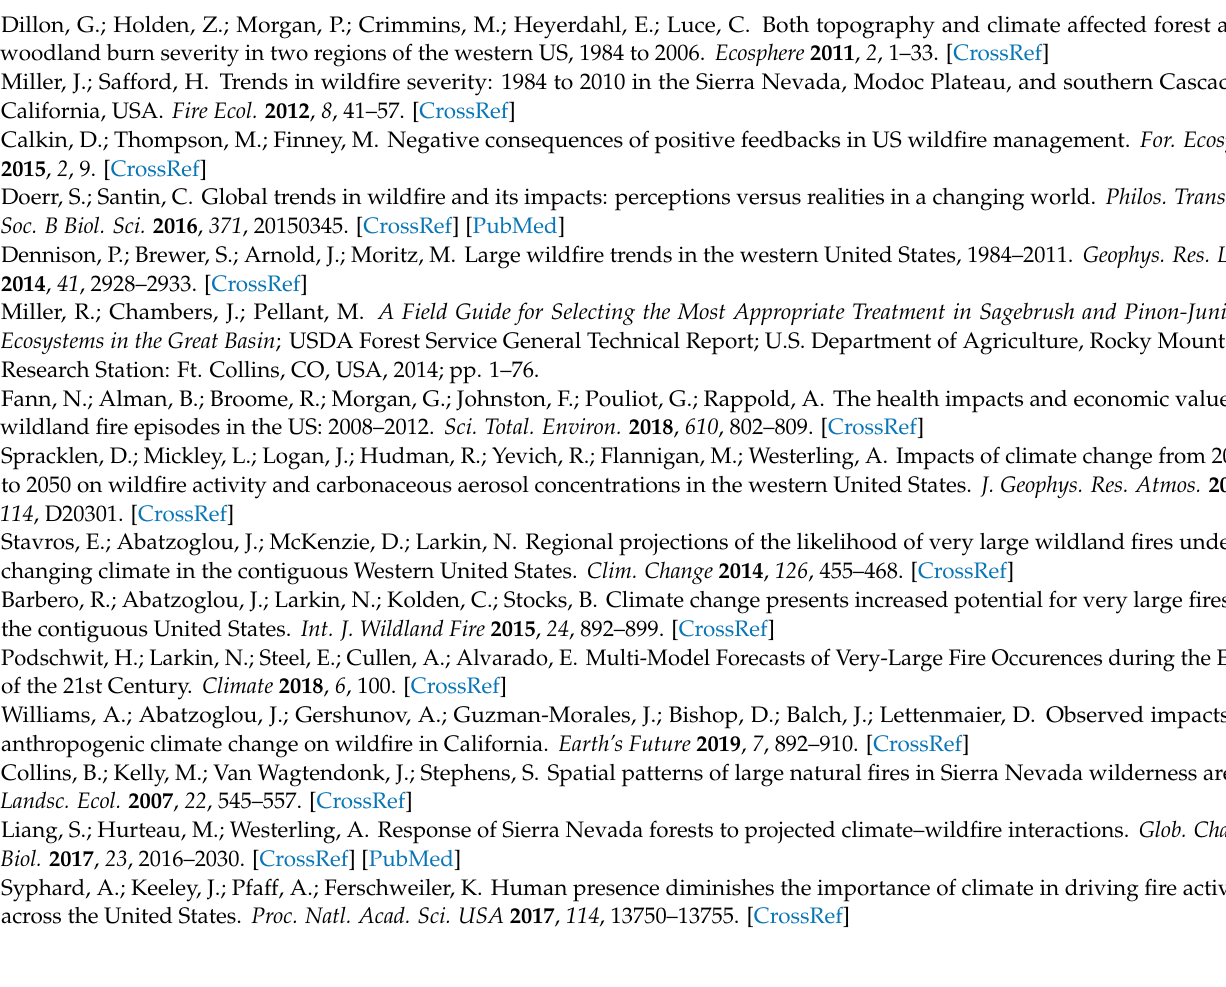
results; Figure S2: Regional relationships between ignitions and low Ta months; Figure S3: Low Ta month anomaly between ignition and non-ignition locations; Figure S4: Differences in the proportion of ignition and non-ignition locations experiencing a low Ta